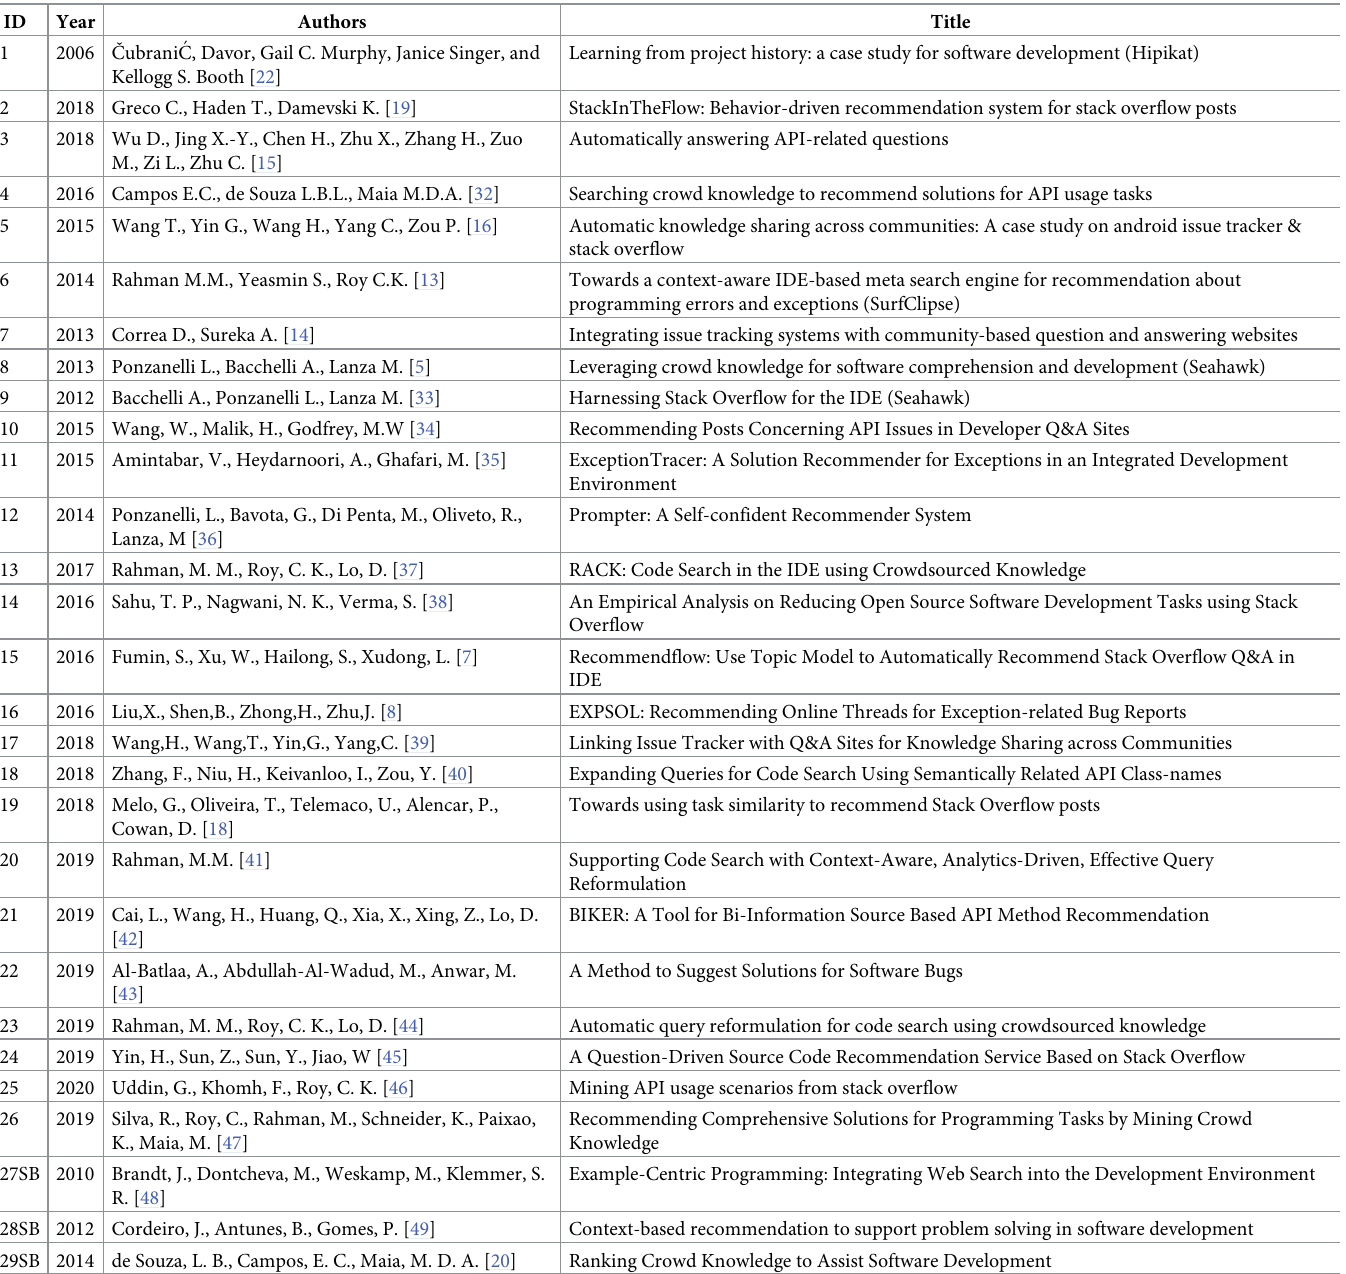
Table 4. Systematic mapping study selected articles after Step